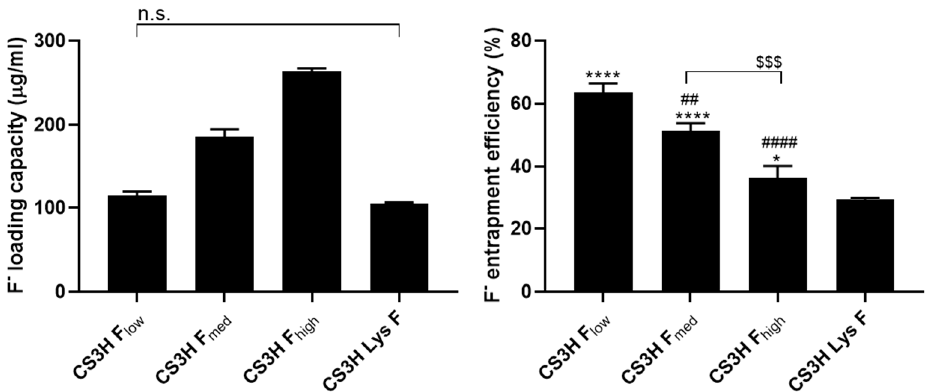
Figure 1. Fluoride ions loading capacity and entrapment efficiency by chitosan polymers. Data are reported as mean ± SD, n = 3. One-way ANOVA returned p < 0.0001 for both sets of data, the results of the Tukey’s multi-comparison test are shown in the graphs. For loading capacity, all comparisons returned a p < 0.0001 unless otherwise indicated. For entrapment efficiency, * p < 0.05, **** p < 0.0001 compared to CS3H Lys F, ## p < 0.01, #### p < 0.0001 compared to CS3H F low and $$$ p < 0.001 comparison as specified on